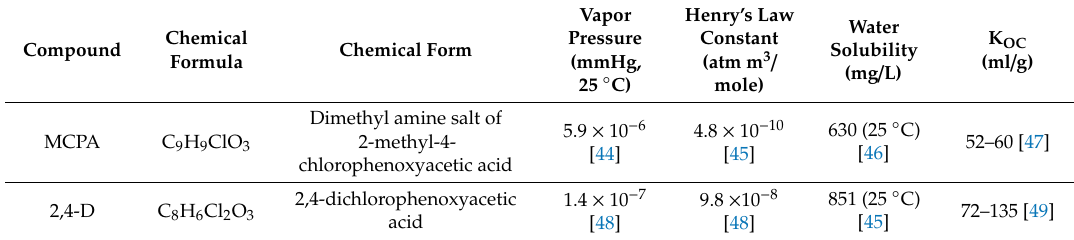
Table 1. Chemical properties of observed herbicides. The K OC is the soil adsorption coe ffi cient and is soil